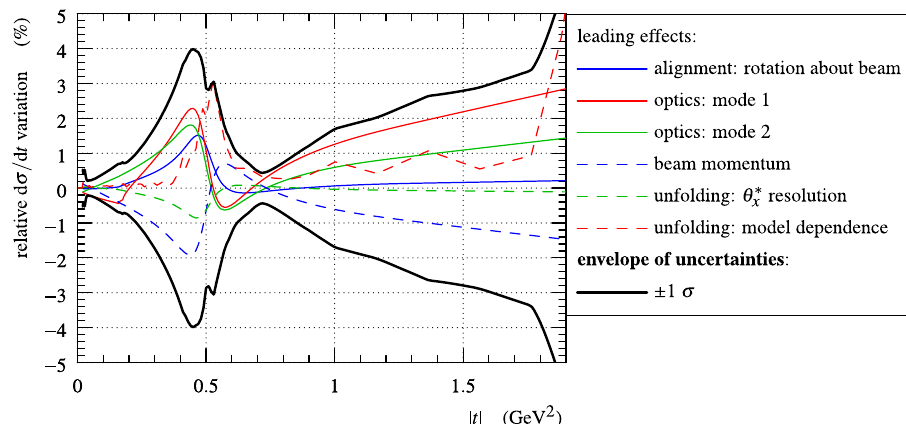
Fig. 2 Impact of t -dependent systematic effects on the differential cross-section. Each colour curve corresponds to a systematic perturbation at 1 σ